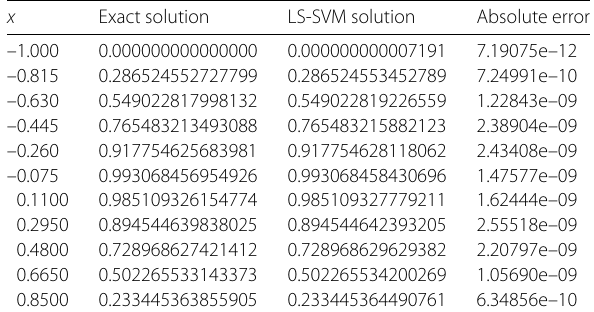
Table 3 Comparison between the exact solution and the LS-SVM solution (Example 3) x Exact solution